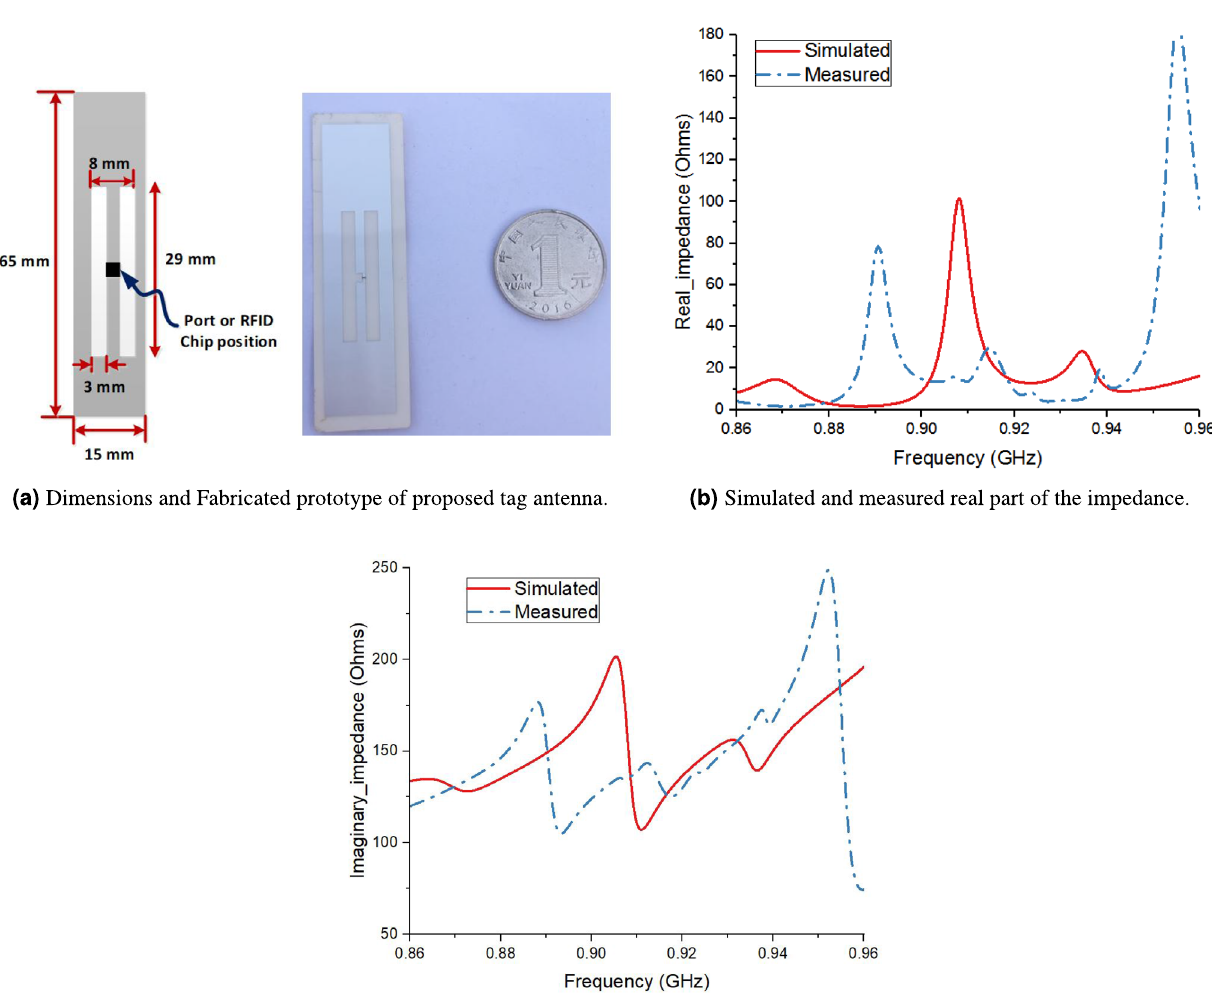
Figure 12. Performance of proposed tag antenna after mounting on a circular water filled plastic bottle using full wave simulation in CST Microwave